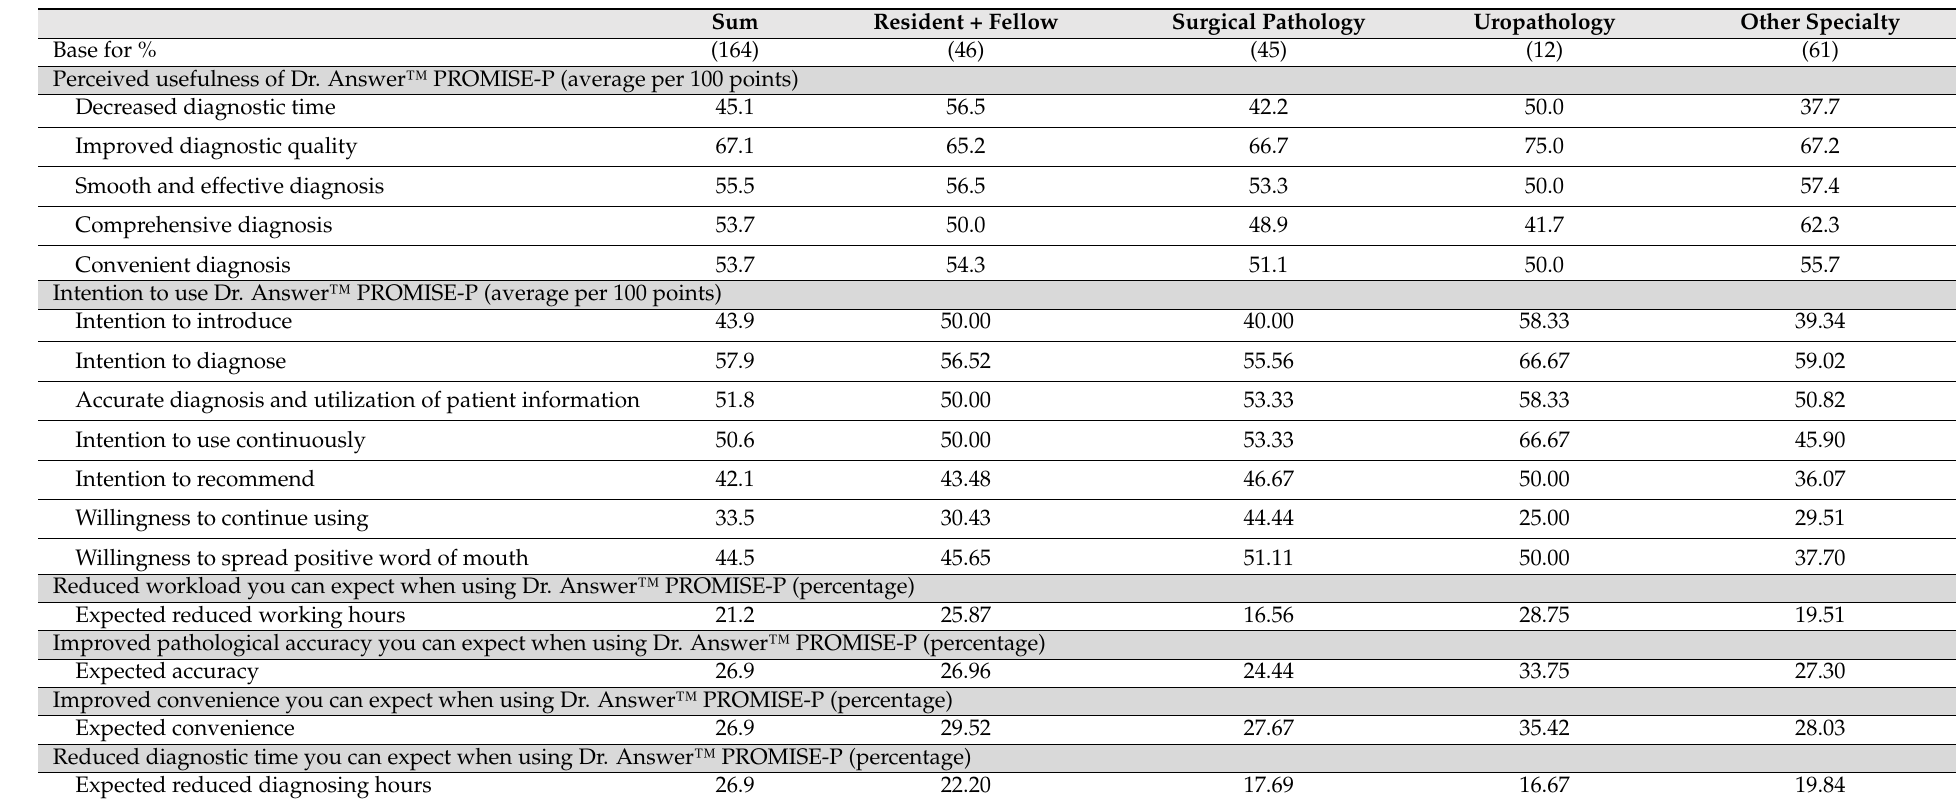
Table 4. The expected usefulness of Dr. Answer™ PROMISE-P by